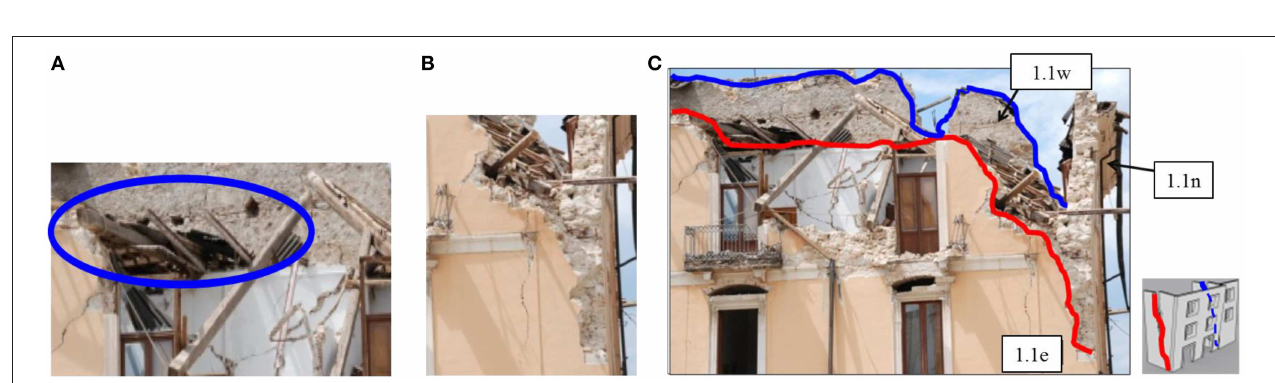
FIGURE 10 | Structural details of the building 1.1. (A) Orthogonal purlins to the façade 1.1e; (B) good corner connection evidenced by good interlocked stones; and (C) identification of the failure mode B2 on the the building 1.1.